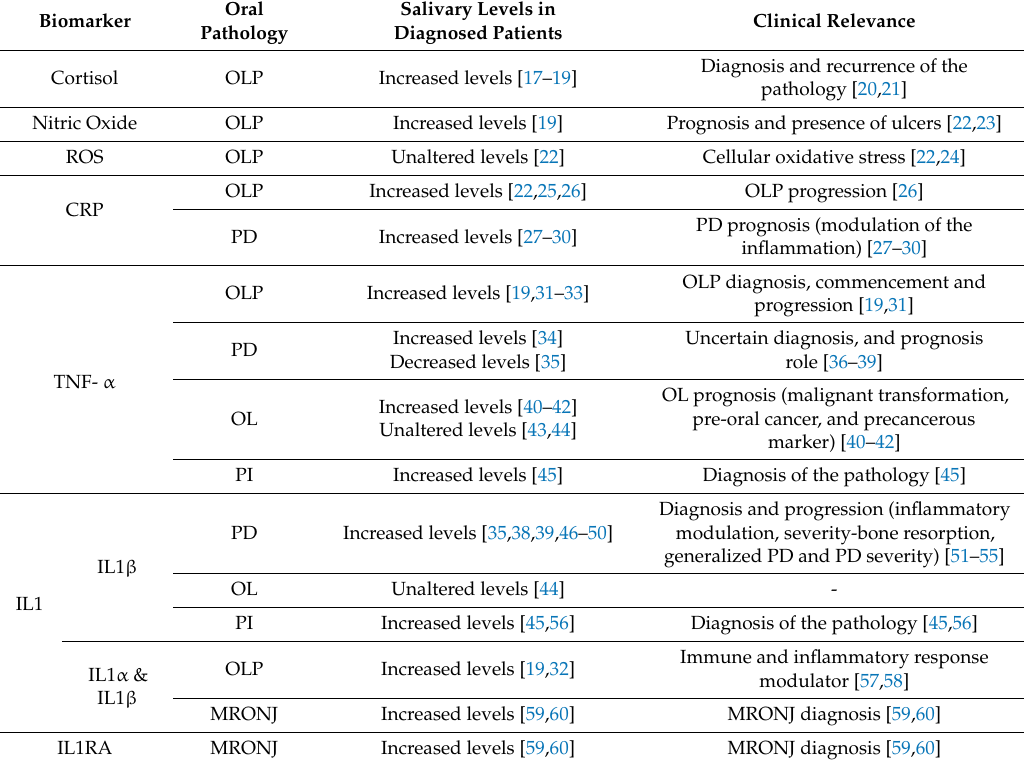
Table 1. Salivary Biomarkers involved in main oral pathologies diagnosis and